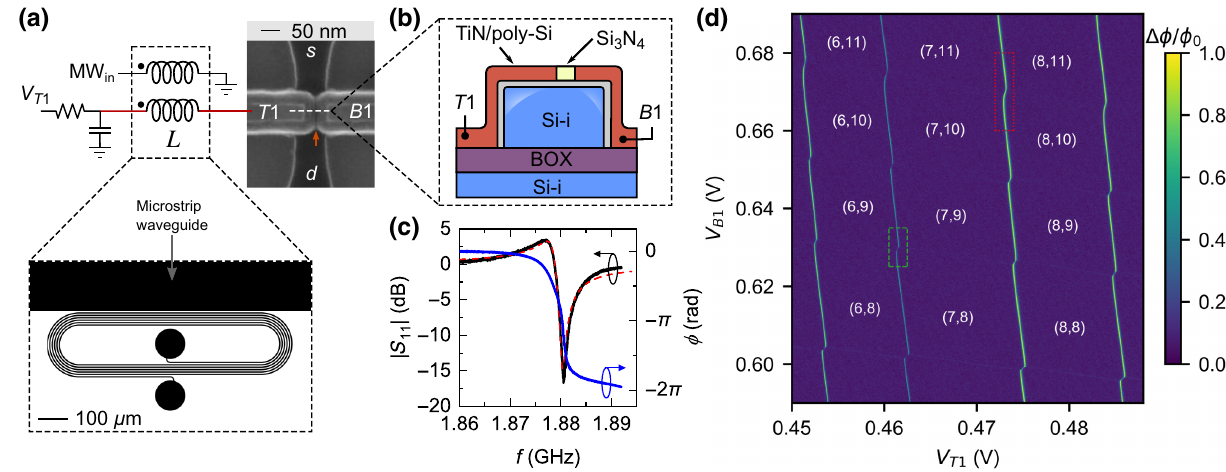
FIG. 1. Measurement setup, resonator geometry, and double quantum-dot characteristics. (a) Two mutually coupled inductors rep- resent the inductive coupling between a microstrip waveguide and a spiral inductor with inductance L , the layout of which is shown below in the dashed box. Both elements are fabricated from the same NbN film on sapphire; the gap separating inductor and waveguide is 4 μ m wide. The inductor is wire bonded to a NWFET on a separate substrate (aluminium wire bonds are highlighted in red). The bias tee consists of a 100-pF capacitor and a 100-k (cid:4) resistor. A SEM image shows a top-down view of a similar split-gate NWFET, where the orange arrow highlights the insulating spacer between the two top gates and its misalignment from the center of the nanowire. (b) Cross-section schematic of the NWFET, cutting through the nanowire perpendicular to its length. Quantum dots are formed in the top corners of the intrinsic silicon body, indicated by white shading. (c) The phase (blue), amplitude (black), and fit (red) of a reflected microwave signal applied and measured at MW in when the terminals of the NWFET are grounded. (d) The DQD charge stability diagram shown in normalized reflected phase data as V T 1 and V B 1 are varied. Numbers in parentheses indicate the electron numbers on each dot; the highlighted ICTs are measured in detail